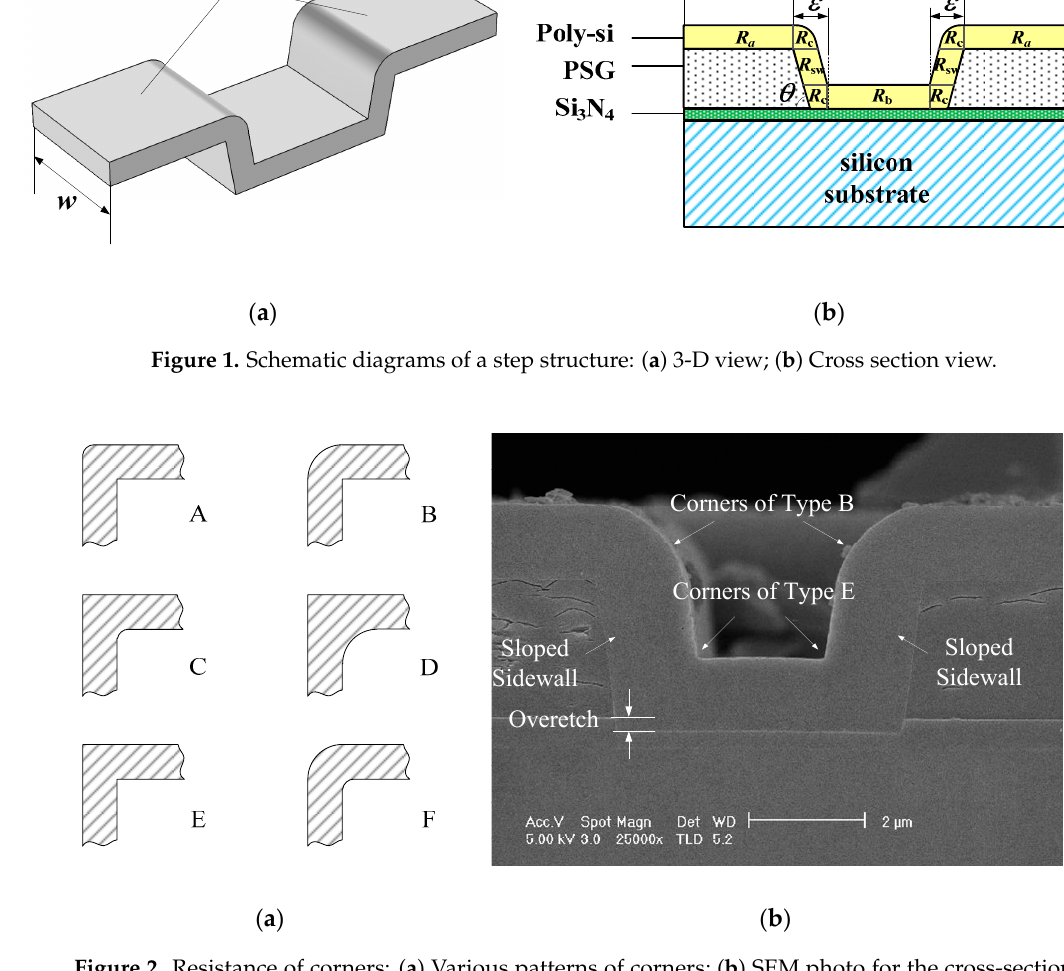
Figure 2. Resistance of corners: ( a ) Various patterns of corners; ( b ) SEM photo for the cross-section view of a step